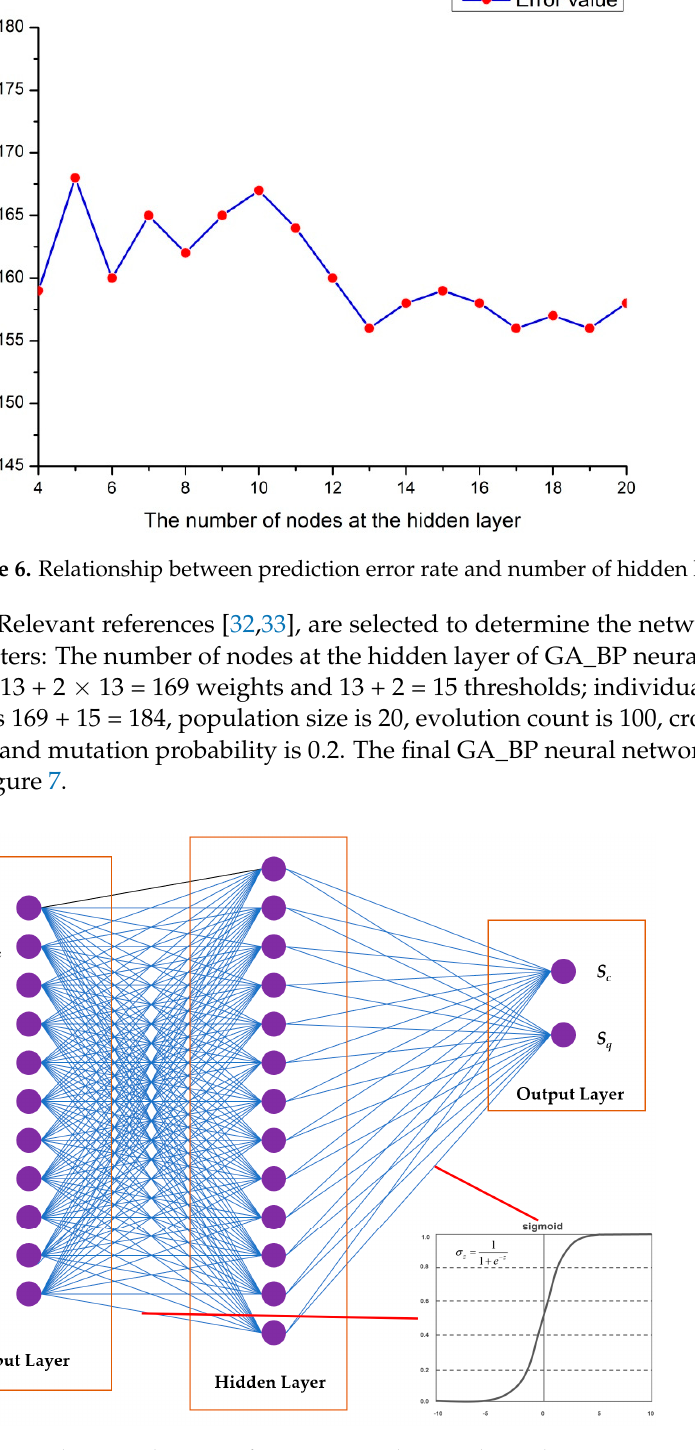
Figure 5. Relationship between sample convergence speed and the number of hidden layer nodes.